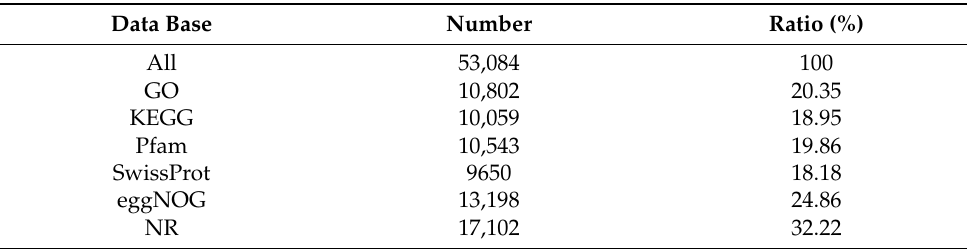
Table 3. Statistics of genes annotated by different databases in S. furcifera females. Data Base